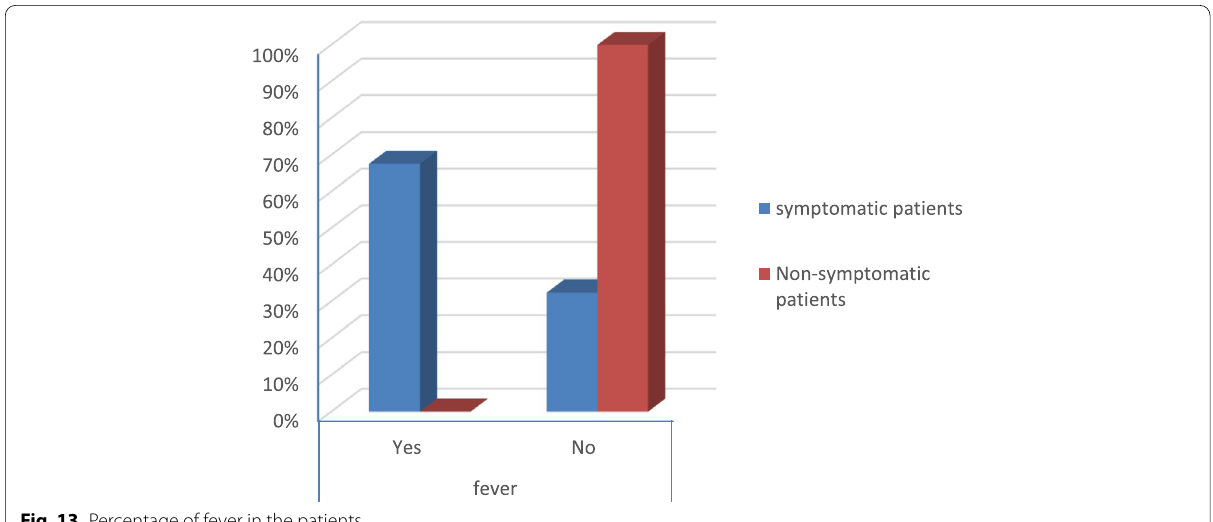
Fig. 13 Percentage of fever in the